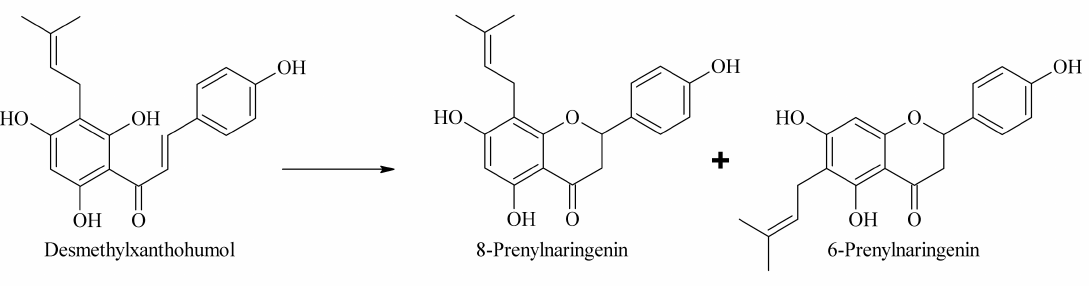
Figure 1. Isomerization of desmethylxanthohumol to 6-prenylnaringenin and